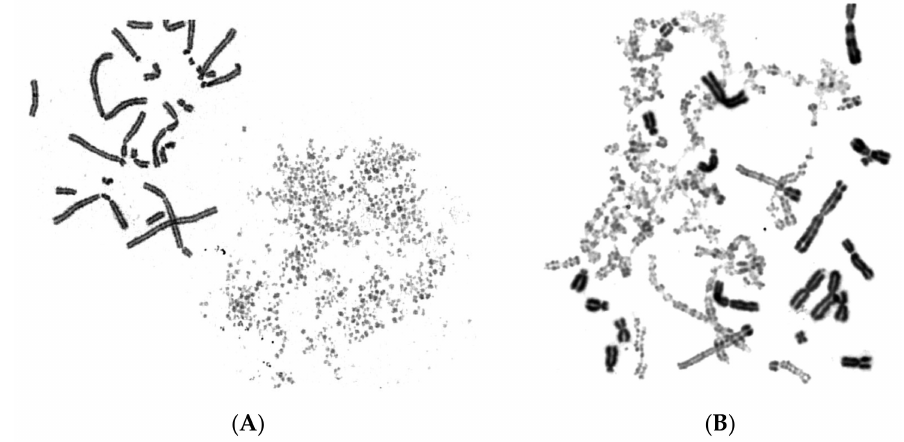
Figure 9. Early-S and late-S induced PCCs in multinucleated CHO cells. When main nuclei in heterophasic multinucleated cells generated by cell fusion procedures using exponentially growing CHO cells enter mitosis, the shattering and morphology of prematurely condensed chromosomes (PCCs) characterizes the stage in S phase of interphase nuclei. Based on the degree of completion of DNA replication, the induced PCCs in interphase nuclei can be classified as early-S ( A ) and late-S phase ( B ).